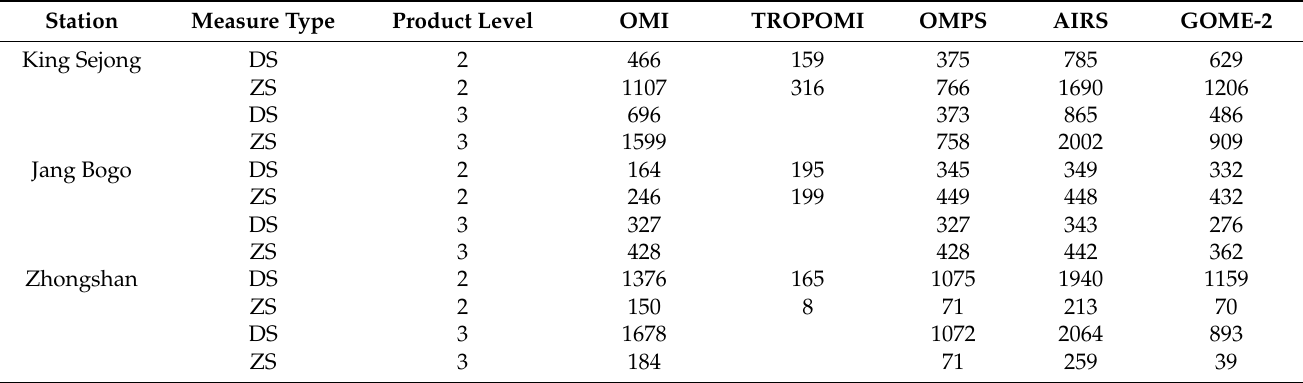
Table 4. The number of data used only when comparing data that exist at the same time among all data calculated at each